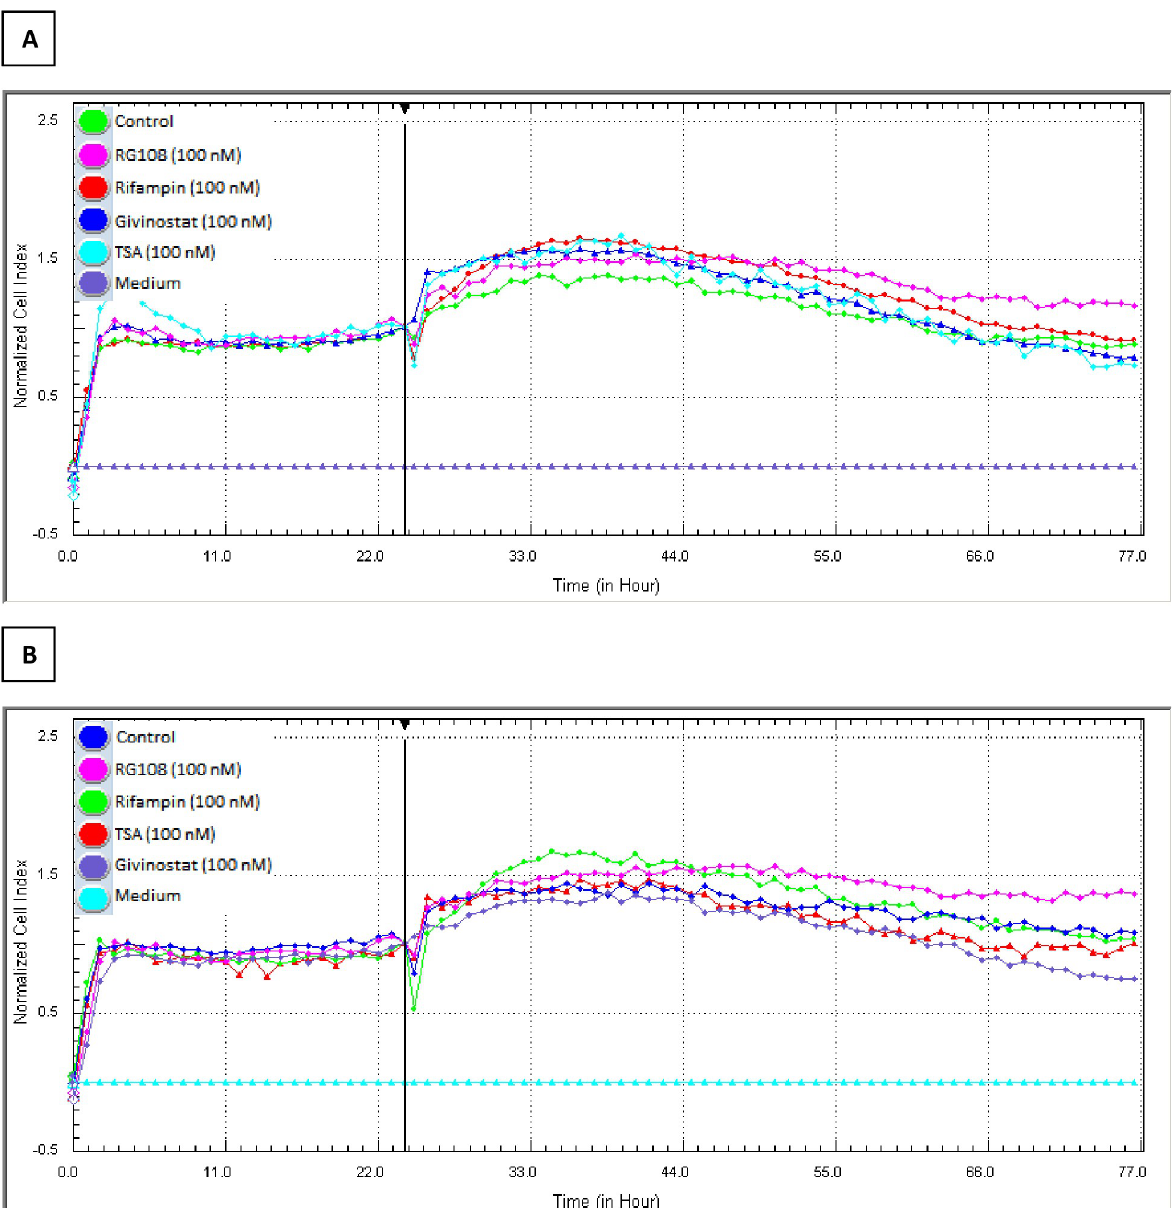
Fig 6. Effects of the treatment groups on HMC3 (A) and differentiated SH-SY5Y (B) cells at 100 nM concentrations. The treatment groups whose neuroprotective effects were tested have no effect on HMC3 and SH-SY5Y cell viability at the chosen concentration (100 nM), as shown by the plateau image of the CI data. 24 hours after seeding the previously differentiated SH-SY5Y and HMC3 cells onto the e-plate, the device was stopped and 100 nM drug concentrations were applied, and the effects were monitored in real time for 48 hours. Data was confirmed in three independent experiments, n = 3 for each treatment